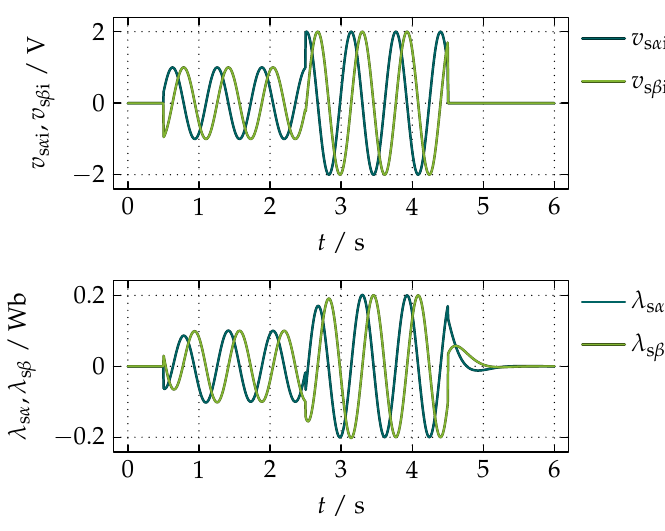
Figure 10. Simulation results of the proposed compensation of the integrational drift for simultaneous steps in the amplitudes of v s α i and v s β i at ω e = 10 rad/s.